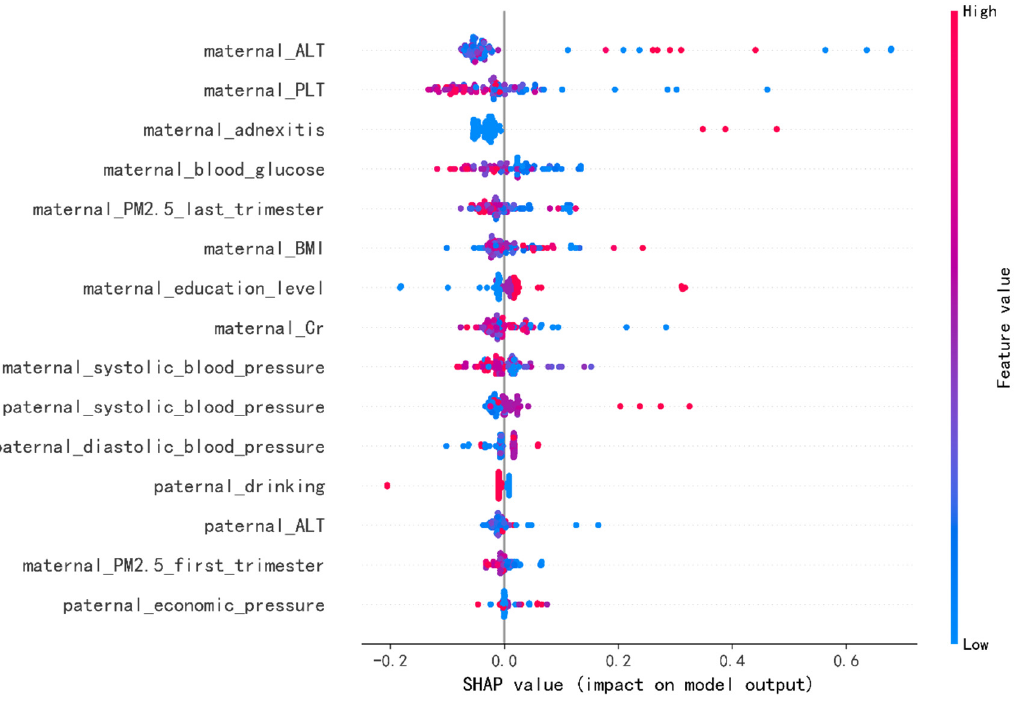
Figure 4. The Shapley Additive Explanation (SHAP) values for most important predictors of small for gestational age (SGA) in the final model. ALT = alanine aminotransferase, PLT = platelet count, BMI = body mass index, Cr = creatinine. Each line represents a feature, and the abscissa is the SHAP value, which represents the degree of influence on the outcome. Each dot represents a sample. Plot is colored red (blue) if the value of the feature is high (low).